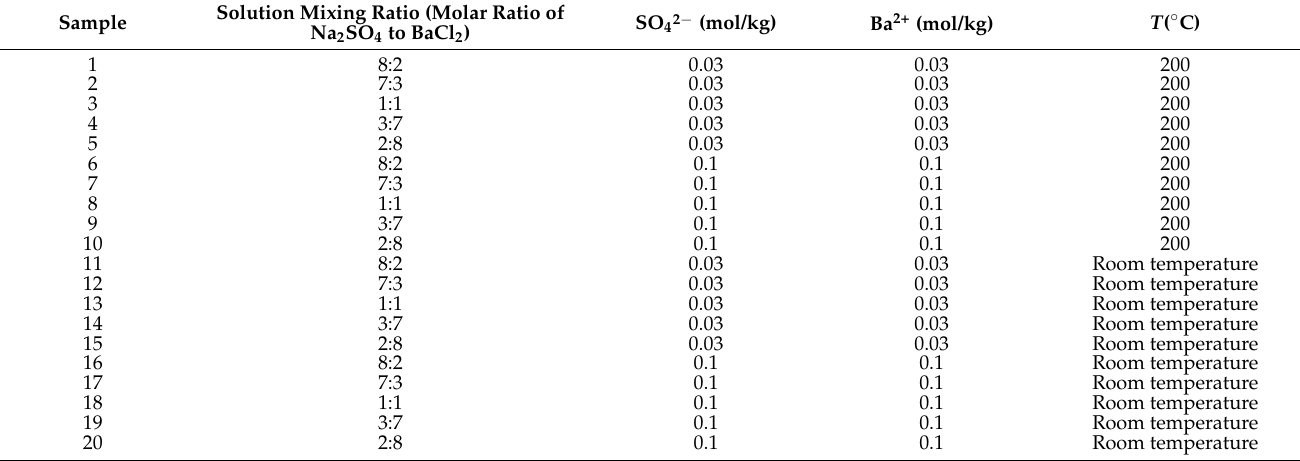
Table 1. The experimental